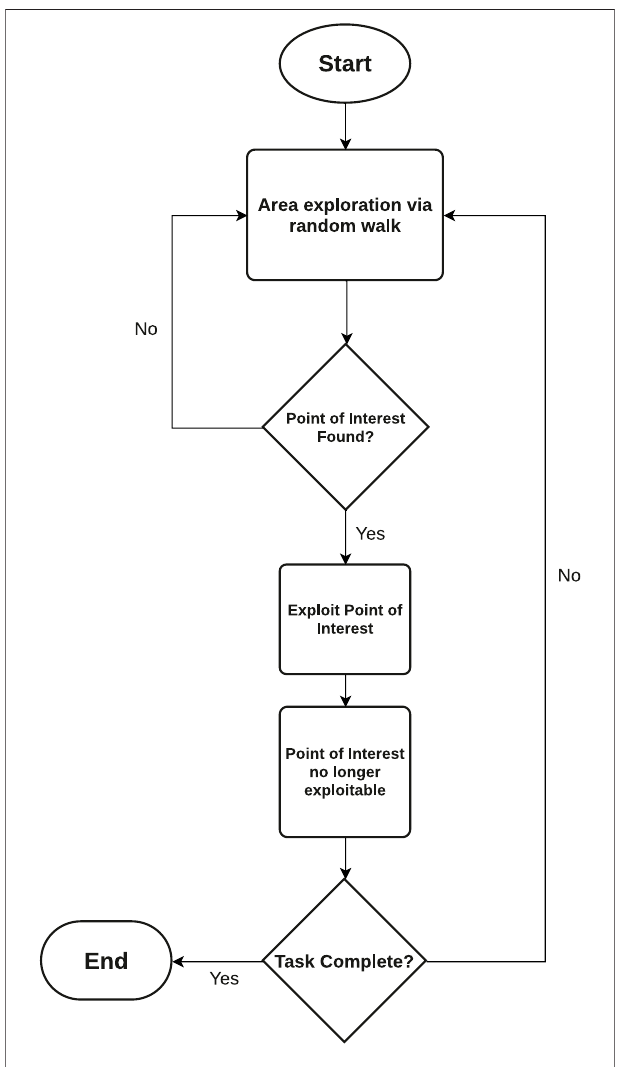
FIGURE 2 | Flowchart detailing how an agent deterministically decides on its response when provoked by environmental stimuli.